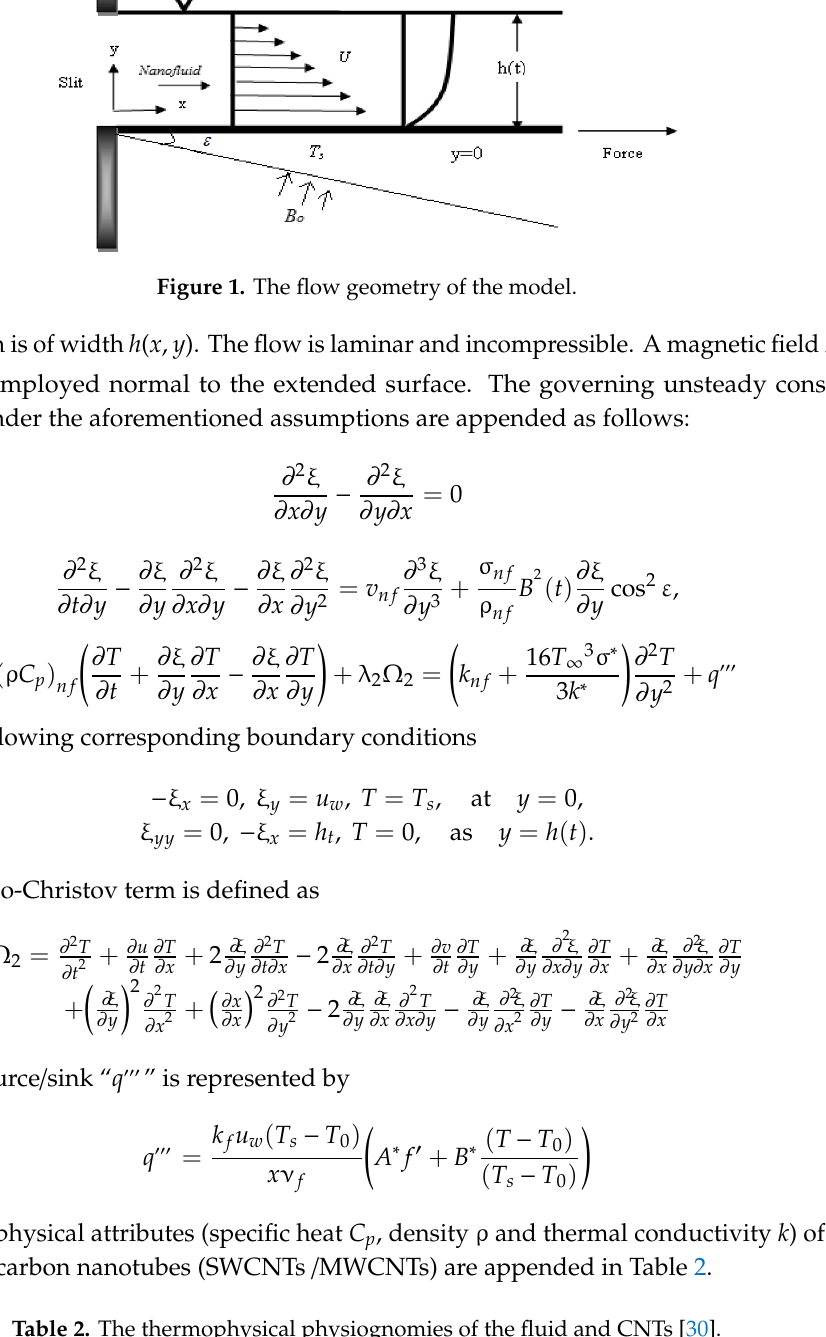
Table 2. The thermophysical physiognomies of the fluid and CNTs